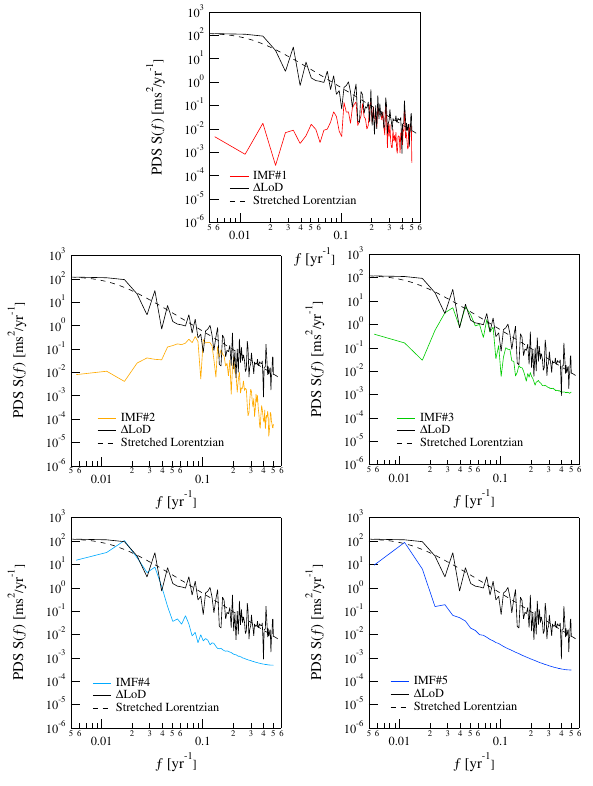
Fig. 3. Comparison between the power spectral density (PSD) of Fig. 3. Comparison among the power spectral density (PSD) of ∆ LoD and the PSDs of each IMF. The dashed 1 LoD and the PSDs of each IMF. The dashed line is a nonlinear line is a nonlinear best fit of the ∆ LoD PSD using a stretched Lorentzian shape (see Eq. 5). best fit of the 1 LoD PSD using a stretched Lorentzian shape (see Eq. 5). comparison among the power spectral densities (PSDs) of the excess LoD ( ∆ LoD ) and of the single IMFs into which the original signal has been decomposed. The sum of the IMF PSDs correctly